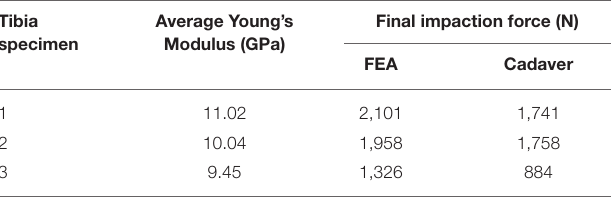
Average Young’s Modulus was calculated from calibrated CT scans of cadaver bones usedinmechanicaltestingandinformingmaterialpropertiesofelementsinthebonemesh for